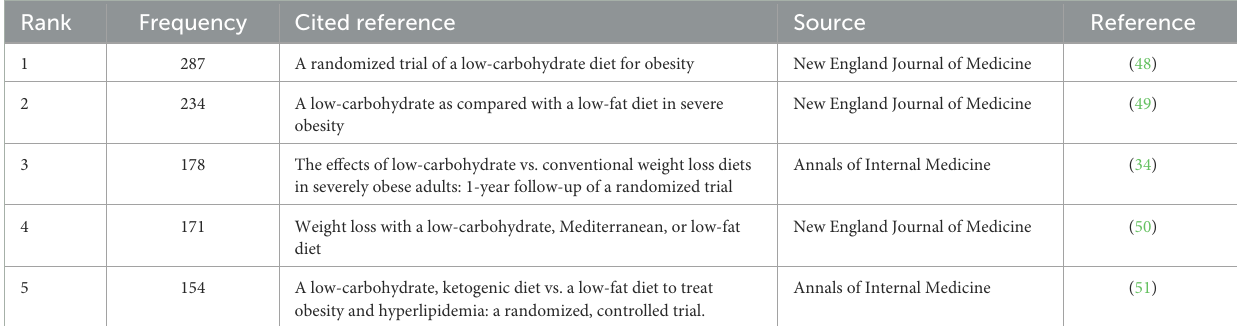
TABLE 6 The top 5 co-cited reference on LChD from 2002 to 2021.